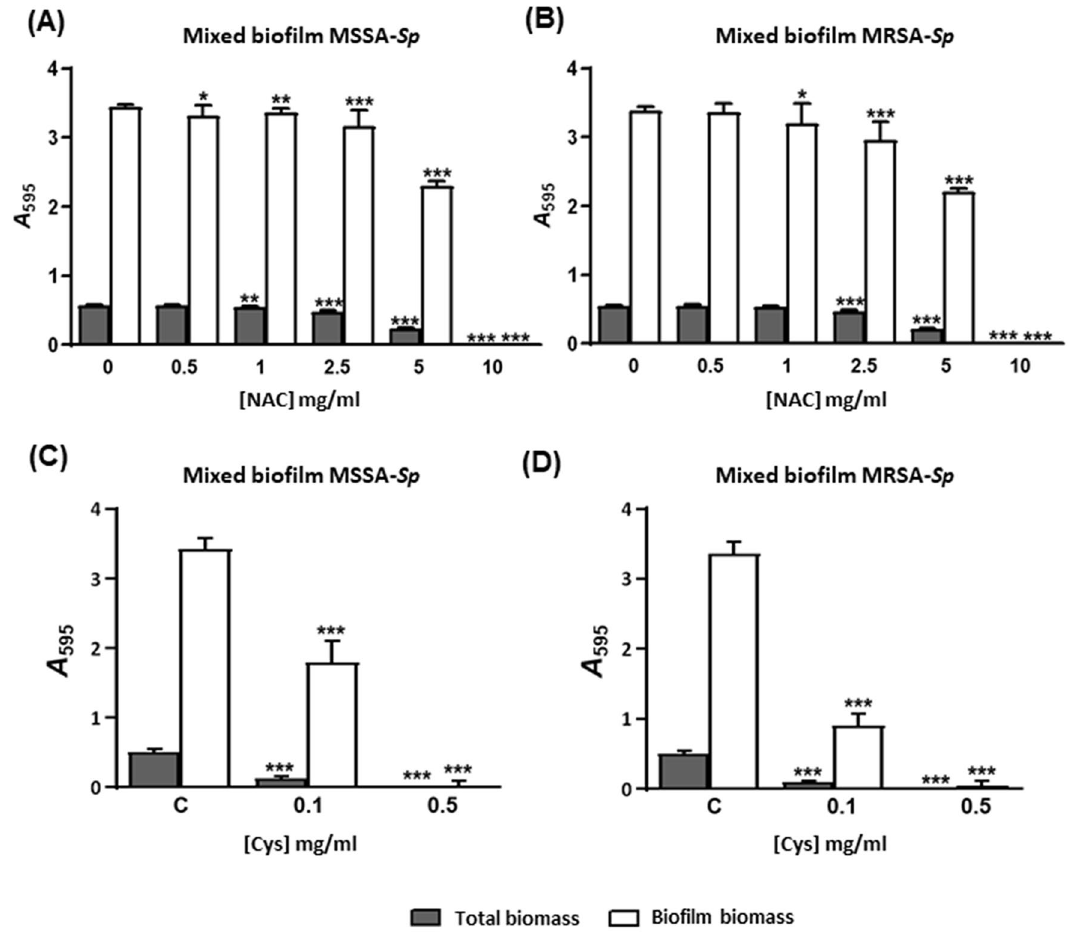
Figure 4. Prevention with antioxidants of MSSA/MRSA- Sp mixed biofilms (Inhibition of mixed biofilms). Mixed biofilms were distributed in the wells of a microtiter plate, which was then incubated for 5 h at 34 °C in the presence of different concentrations of NAC ( A , B ) or Cys ( C , D ). The MIC of NAC for the S. pneumoniae strain was 2.5 mg/ml and 5 mg/ml for both MSSA /MRSA strains whereas the MIC of Cys for the S. pneumoniae strain and both S. aureus strains was 0.156 mg/ml. Absorbance levels after CV staining of mixed biofilms ( A ) and ( C ) MSSA- Sp ( B ) and ( D ) MRSA- Sp . Dark grey bars represent total biomass (adherent plus non-adherent cells) and white bars represent mixed biofilm biomass. Data represent the average of at least three experiments. Standard deviation bars are shown, and asterisks mark statistically significant results (two-tailed Student’s t test: * P < 0.05; ** P < 0.01; *** P < 0.001) when comparing the treatment versus the non-treated biofilm. For multiple comparisons, we performed one-way ANOVA obtaining *** P < 0.001 in all the